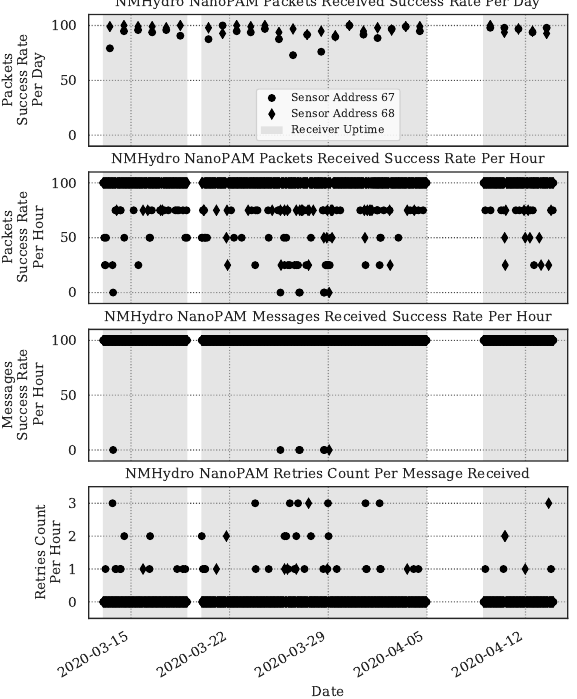
Figure 18. NM SDR NanoPAM packet and message success per day and per hour. Analysis is over